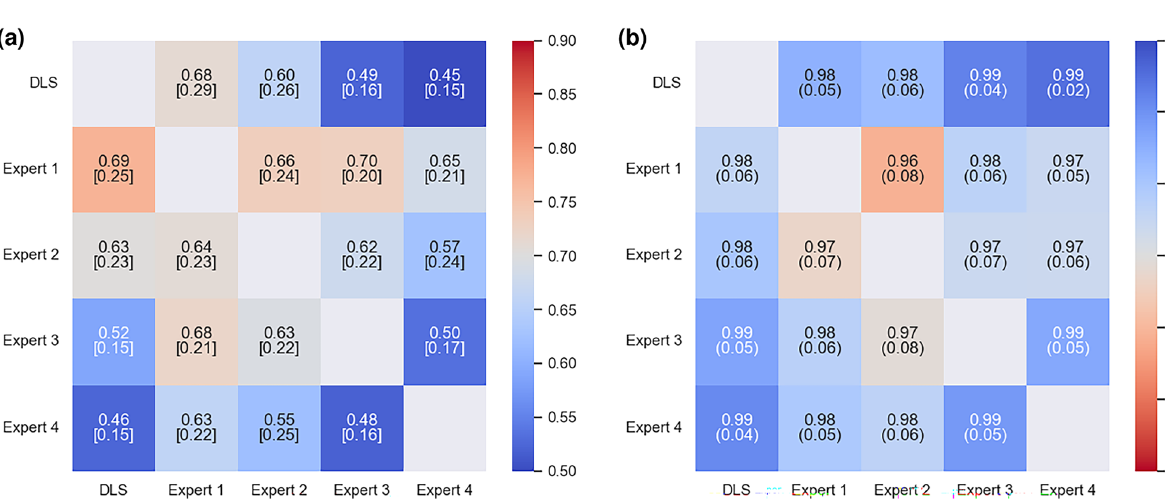
Figure 3. Pairwise comparison of the Experts and the deep learning system (DLS). Each row represents which assessment was used as the ground truth and each column which was used as the estimate. The mean curve distance measure is asymmetric, which results in asymmetric matrices. ( a ) Median and interquartile range [IQR] of curve distances in millimetres. ( b ) The mean (SD) of the proportion of the canal within a 2.0 mm margin.